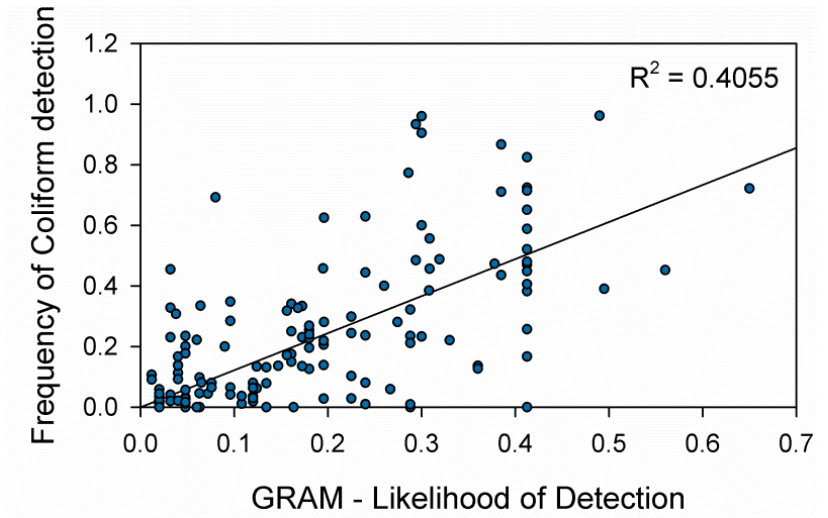
Figure 9. GRAM likelihood vs. actual coliform detection.